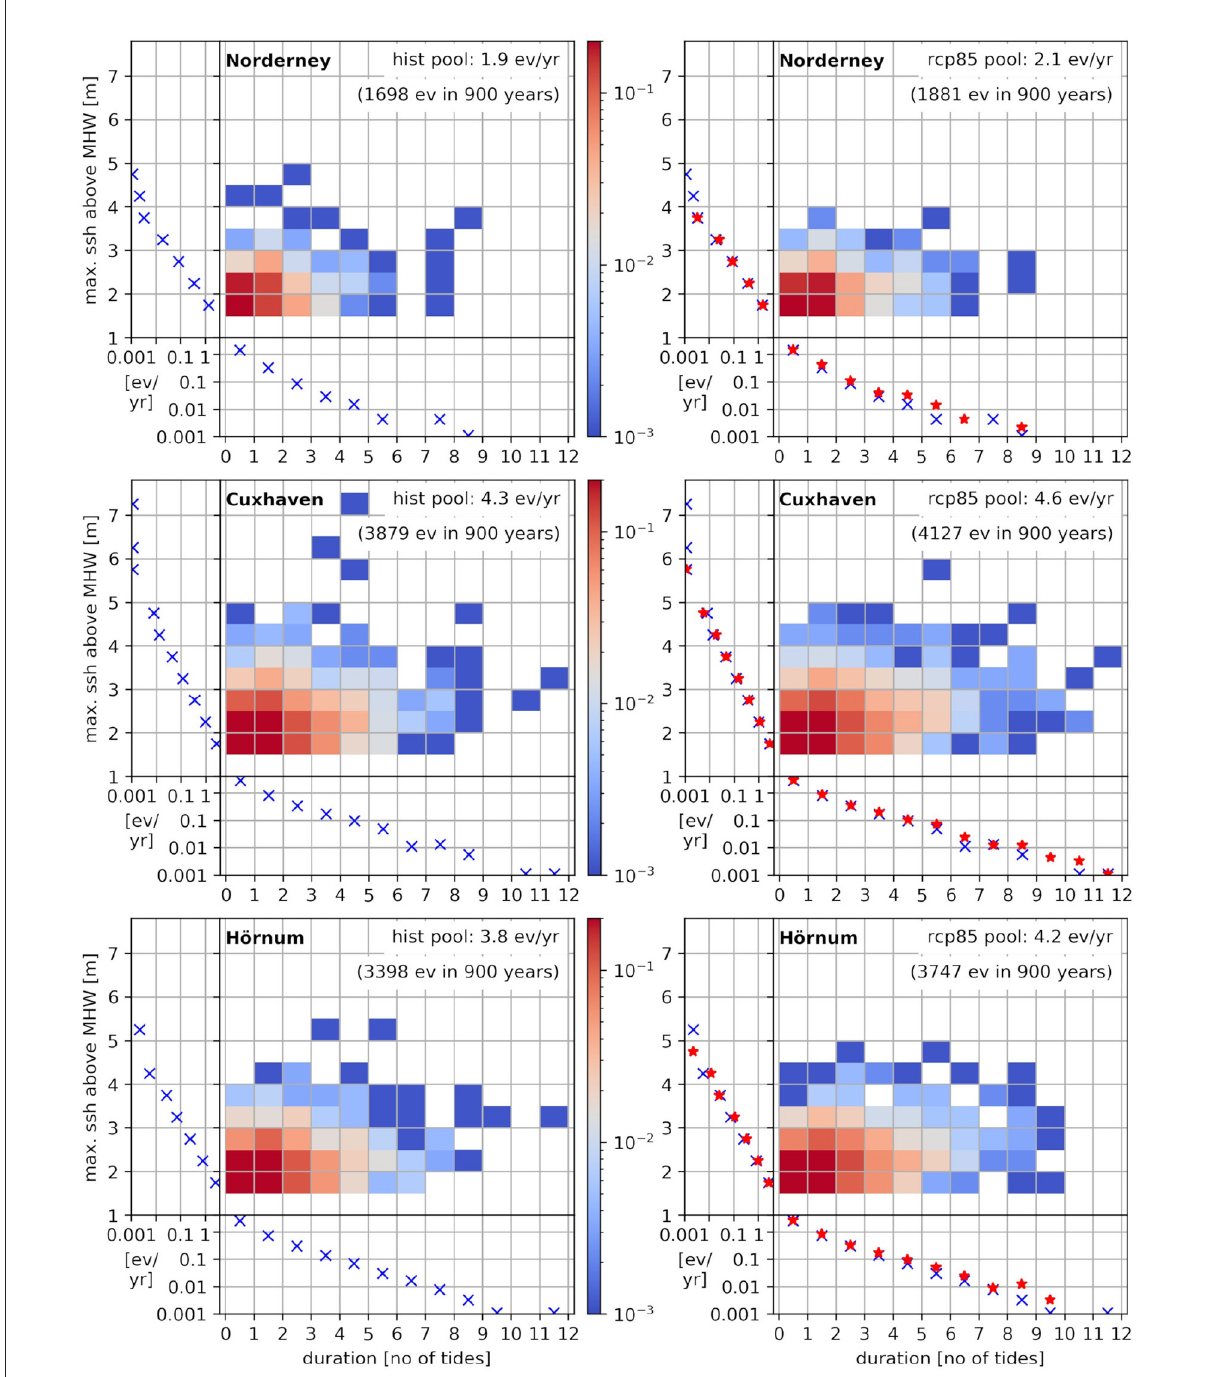
FIGURE6 Clustered storm surge events: duration in numbers of tidal periods (12.425 h, 0–1 means up to 1 tidal period) vs. highest SSH (0.5 m bins) for historical and rcp85 pools ( left and right ) at Norderney, Cuxhaven, and Hörnum ( top to bottom ). Shading gives the number of events per year. Diagrams on the left and bottom of each histogram display numbers of all events per year summed over all durations and over all heights, respectively. The right diagrams show both the historical (blue crosses) and the RCP8.5 sums (red